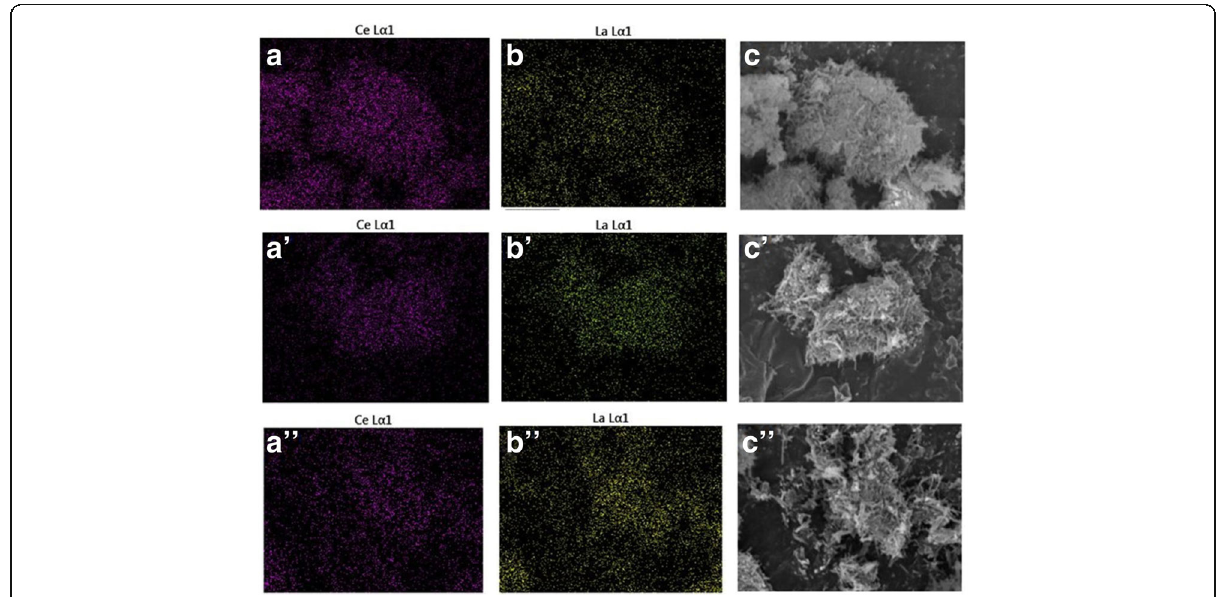
Fig. 4 The element mapping images of Ce and La, SEM images of the mixed samples for Ce-La nanorods with La contents of 25 at.% ( a – c ), 50 at.% ( a ′– c ′ ), 75 at.% ( a ′′– c ″